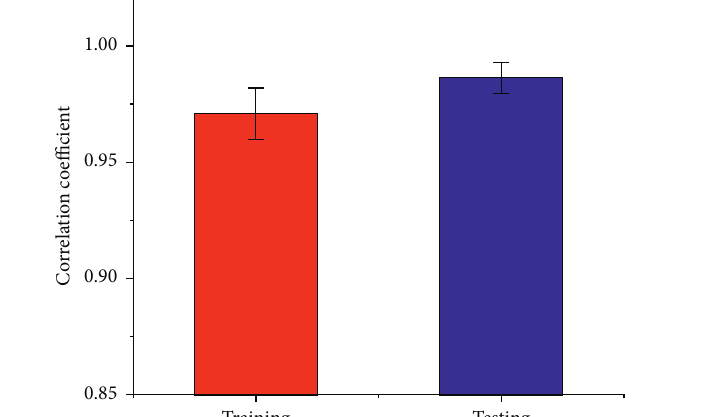
Figure 14: The performance of the optimum DNN model on the training set and the testing